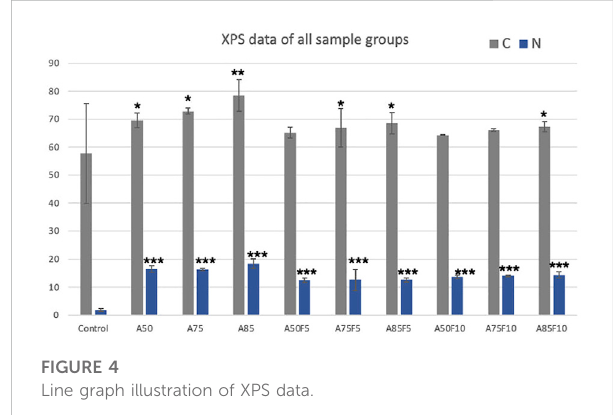
FIGURE 4 Line graph illustration of XPS